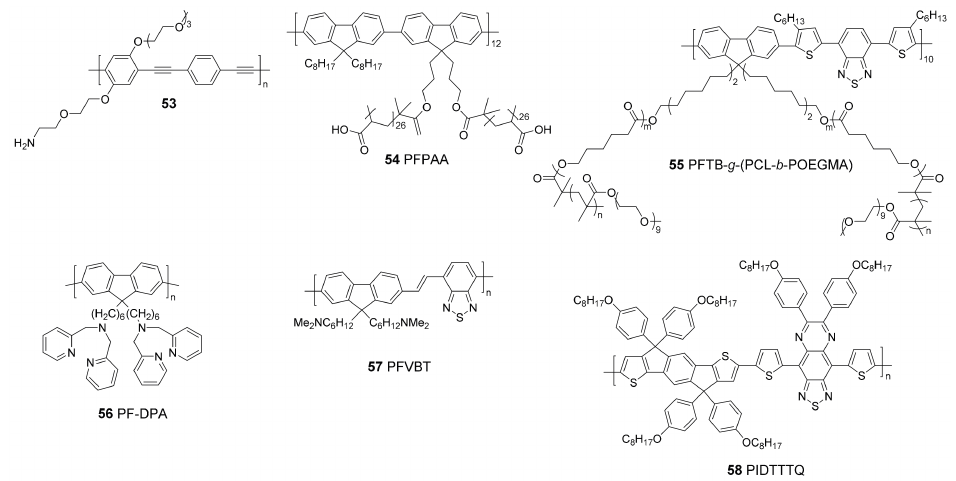
Figure 13. Cartoon-like visualization of the basic concepts of theranostics: ( a ) a patient with cancer is administered a theranostic agent, which is used to visualize the tumor ( b ) and, at the same time, can be activated by a laser to produce reactive oxygen species or heat to damage the cancer cells ( c ). The theranostic NPs can also be loaded with a drug, which is released at the tumor site. Tumor reduction can be observed in situ because of the fluorescent nature of the agent ( d ).